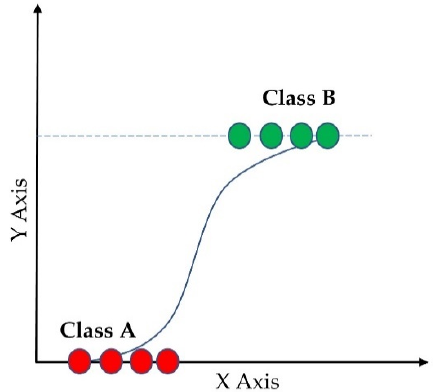
Figure 5. Logistic regression of binary classification.